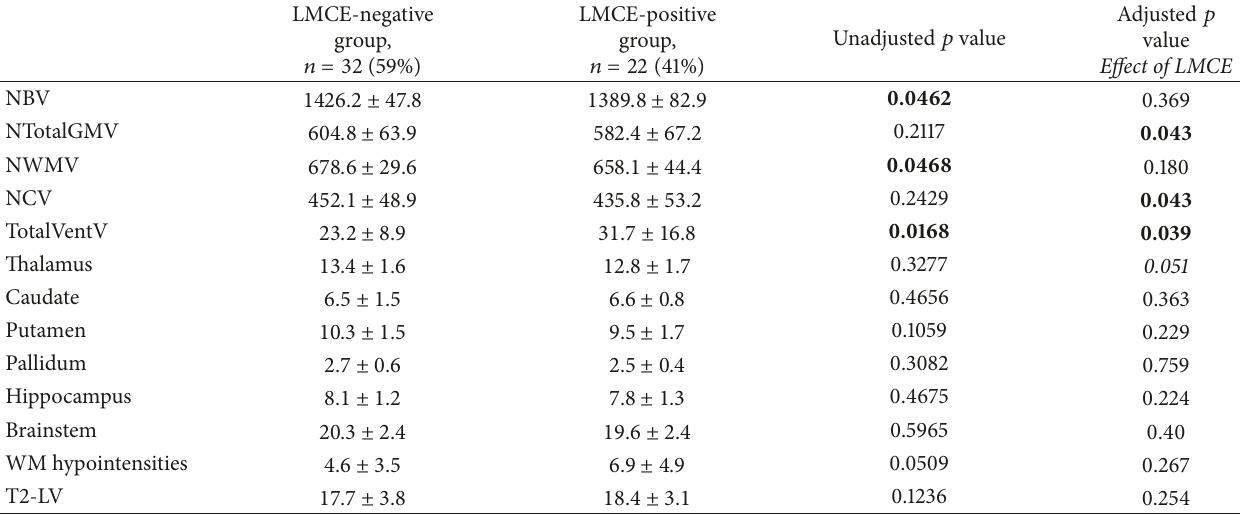
Table 3: Brain morphometry analysis according to the LMCE